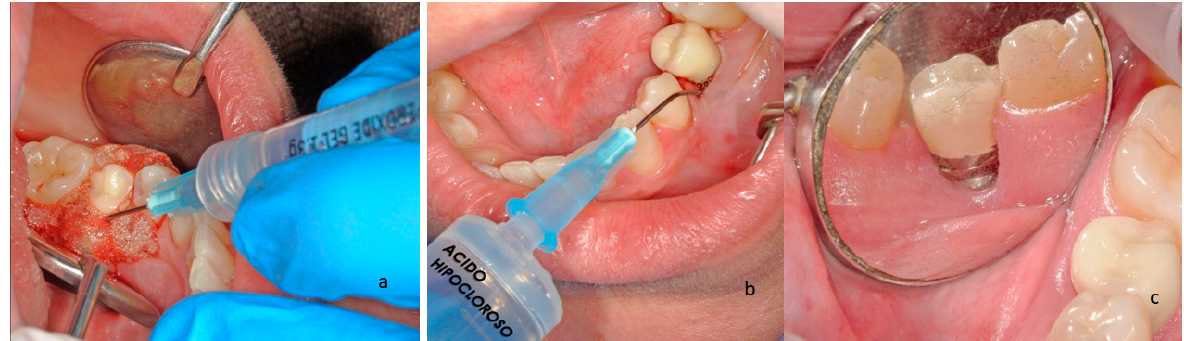
Figure 2. ( a ). Hydrogen peroxide treatment on the titanium surface after the mechanical modification. ( b ). Hypochlorous acid treatment. ( c ). The implant and the soft tissues after three weeks.